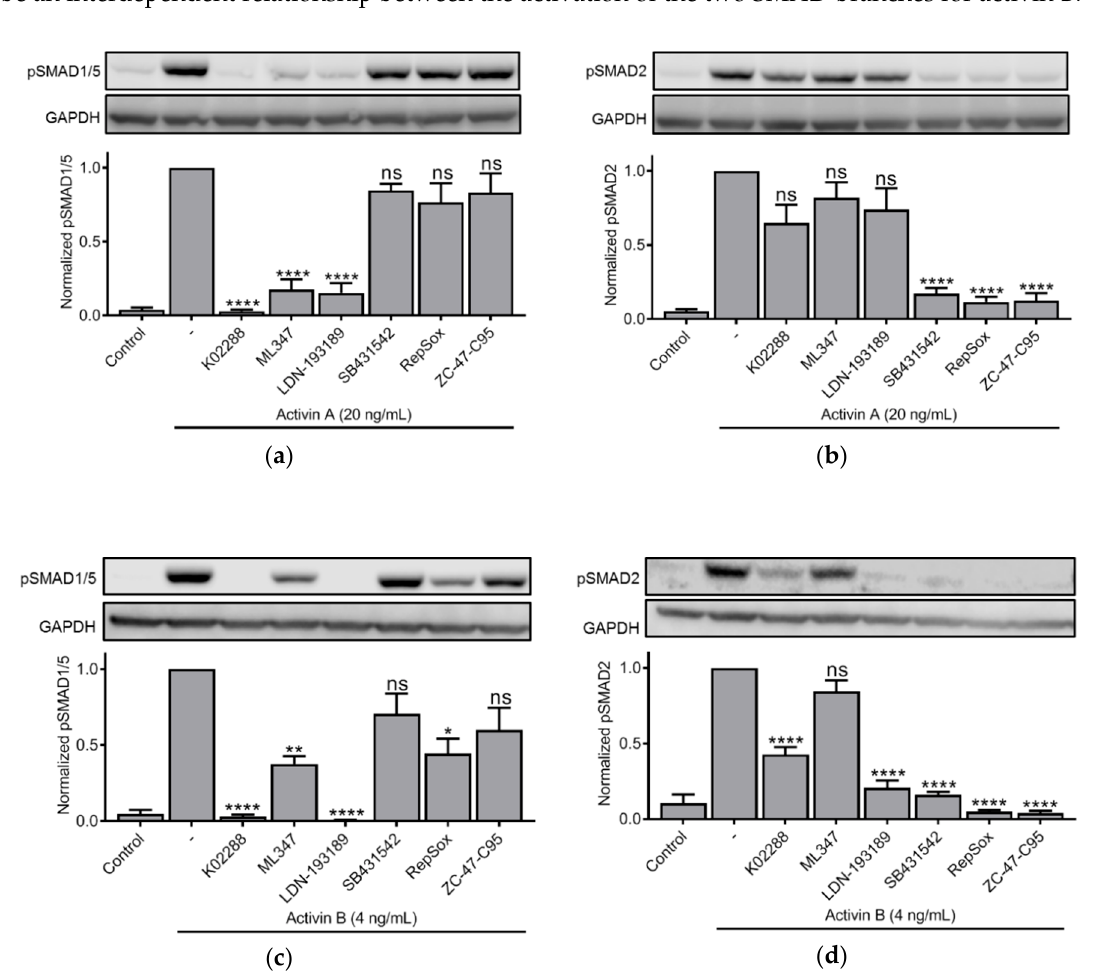
Figure 3. E ff ect of small molecule inhibitors on activin-induced SMAD phosphorylation. IH-1 myeloma cells were treated for one hour with activin A (20 ng / mL) ( a , b ) or activin B (4 ng / mL) ( c , d ) with or without di ff erent inhibitors. K02288, LDN-193189 and RepSox (100 nM), ML347 (200 nM), ZC-47-C95 (1 µ M) and SB431542 (2 µ M). Then, the phosphorylation status of SMAD1 / 5 and SMAD2 was measured by western blot. Representative experiments are shown (upper panels) and relative activation was calculated based on signal intensities of the SMADs and GAPDH for normalization (lower panels). The graphs represent mean ± s.e.m. of n = 3 independent experiments. One-way ANOVA and Dunnett’s multiple comparisons test were performed (* p ≤ 0.05, ** p ≤ 0.01, **** p ≤ 0.0001, ns (not significant) p >